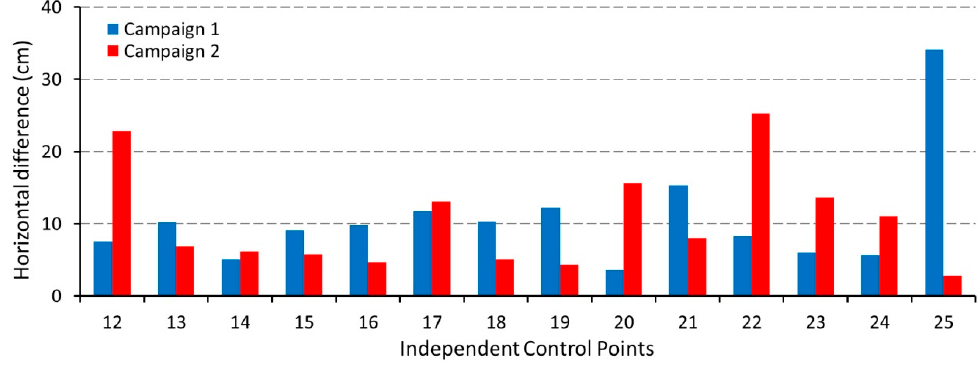
Figure 11. Horizontal differences between GNSS ICPs and orthomosaics from campaigns 1 and 2.